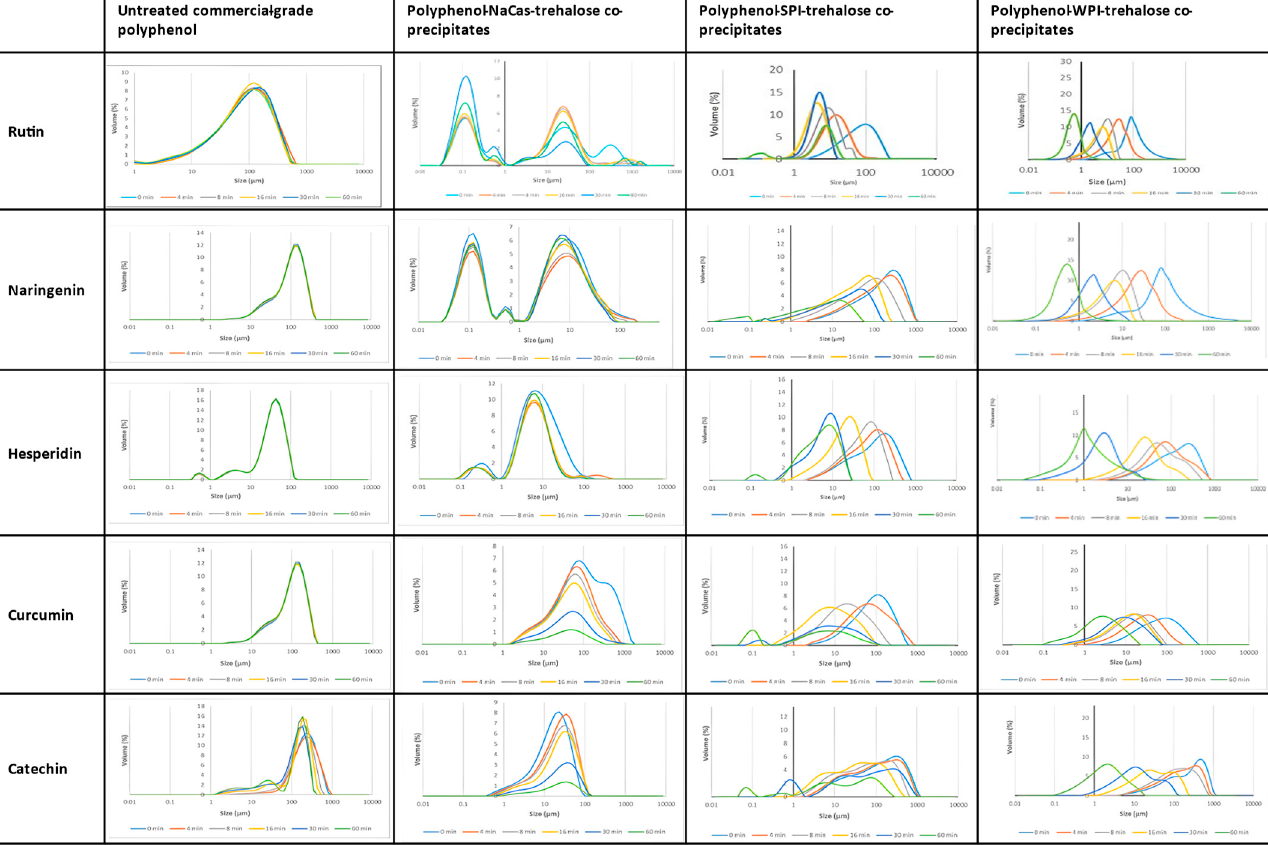
Figure 4. The size distribution of particles over time of the powders of untreated polyphenols and the co-precipitates of each polyphenol with different proteins in the presence of trehalose, dispersed in phosphate buffer (pH 7.0). NaCas: sodium caseinate, SPI: soy protein isolate, and WPI: whey protein isolate. Coloring is as follows: 0 (actually 2) min, cyan; 4 min orange; 8 min, grey; 16 min, yellow; 30 min, blue; 60 min, green. The distance scale extends from 0.01 nm to 10,000 nm, with the exceptions of the co-precipitate of naringenin with NaCas and trehalose where it is 0.01 nm to 100 nm, and untreated rutin where it is 1 nm to 10,000 nm.